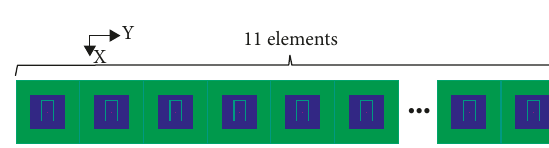
Figure 5: The arrangement of the 11-element